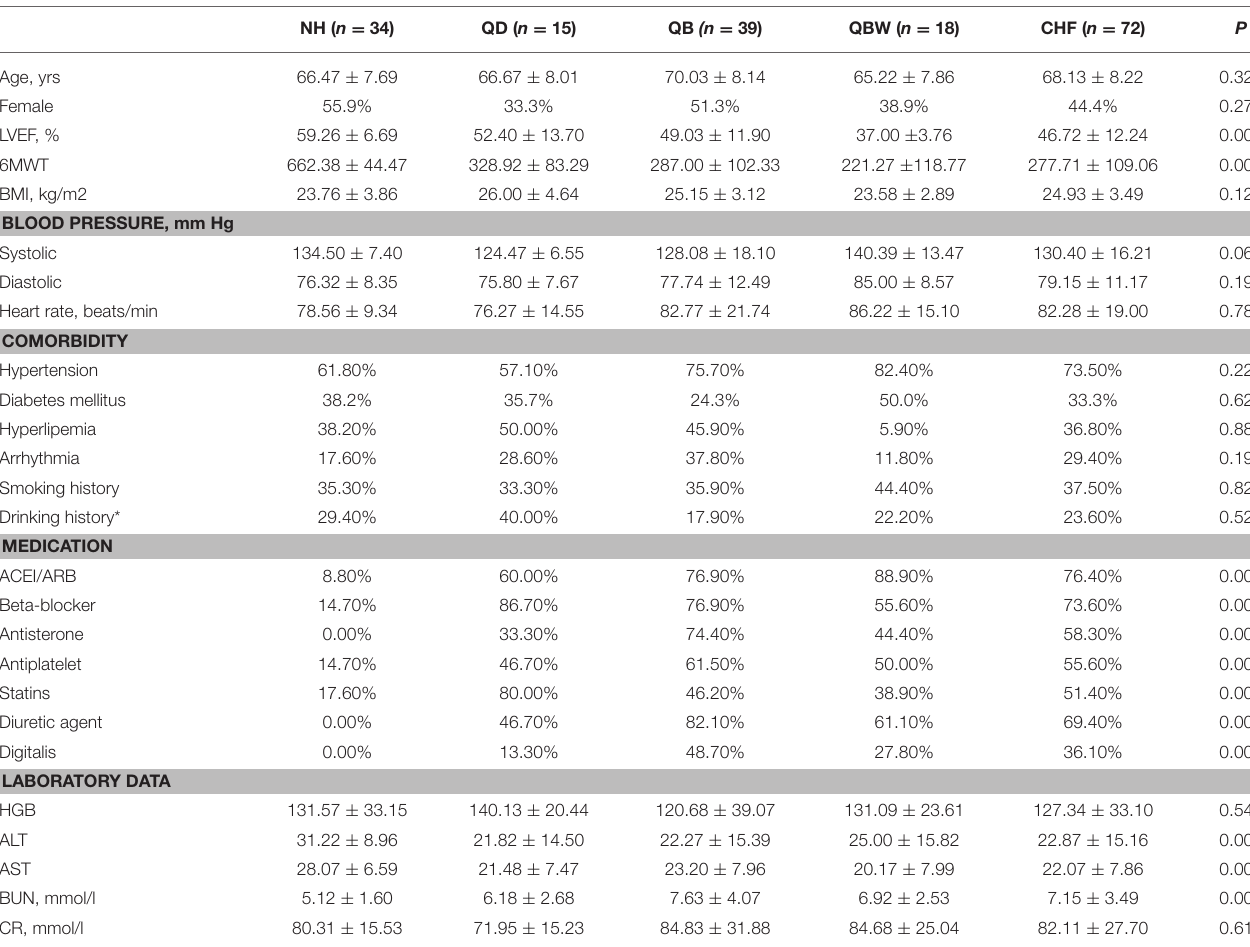
TABLE 1 | Baseline characteristics of discovery phase